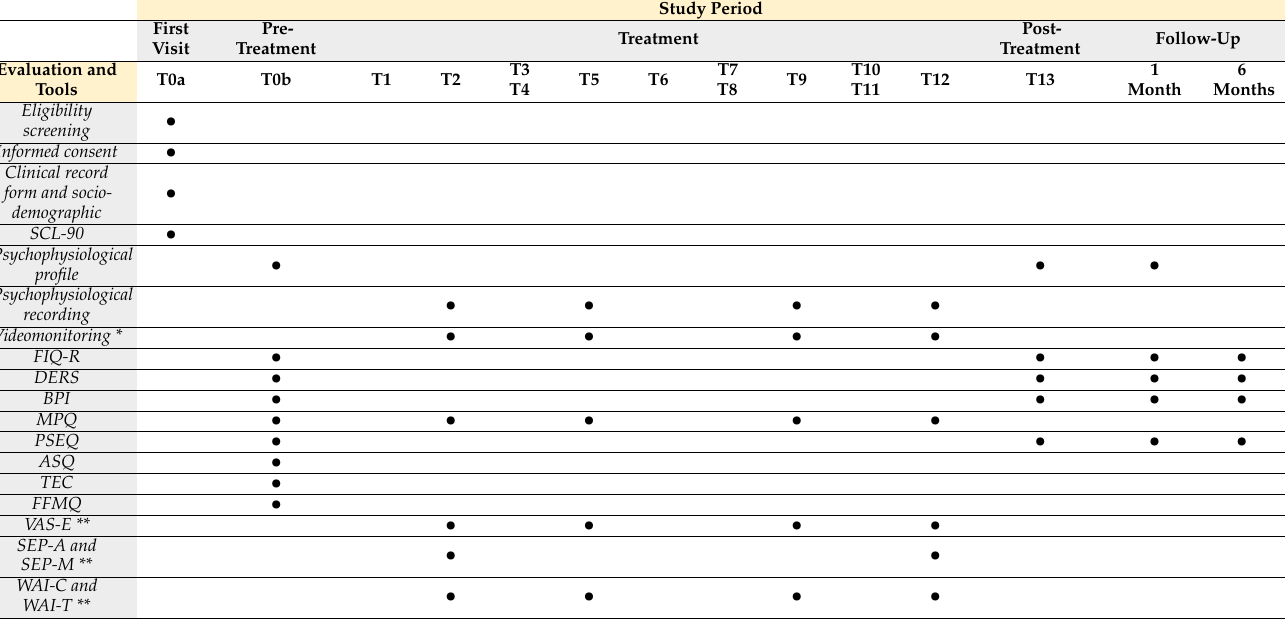
Table 1. Evaluation